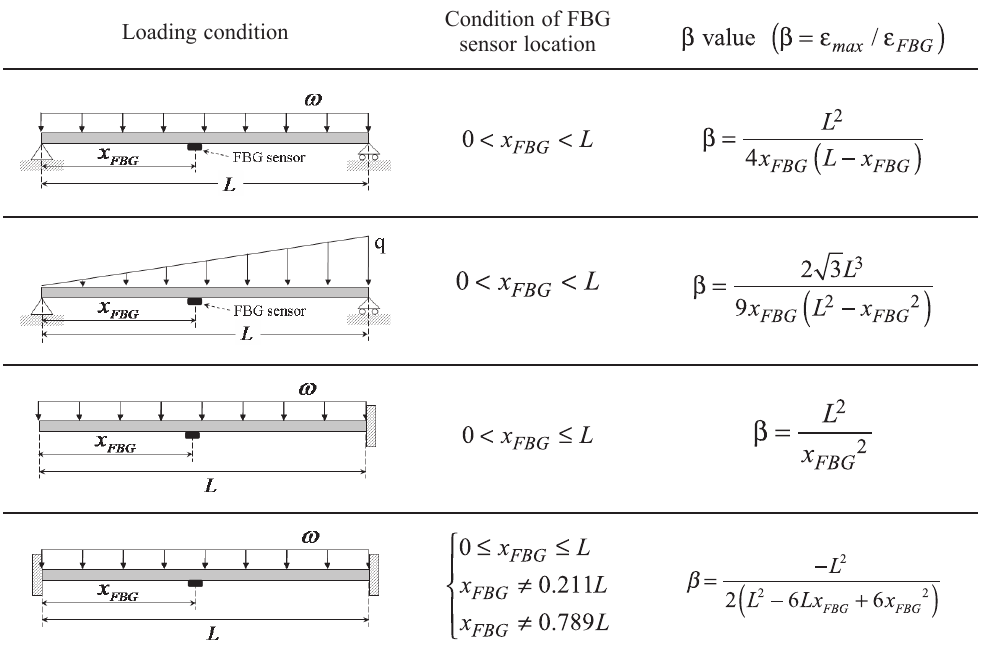
Table 1. Values of β for the beams subjected to distributed load